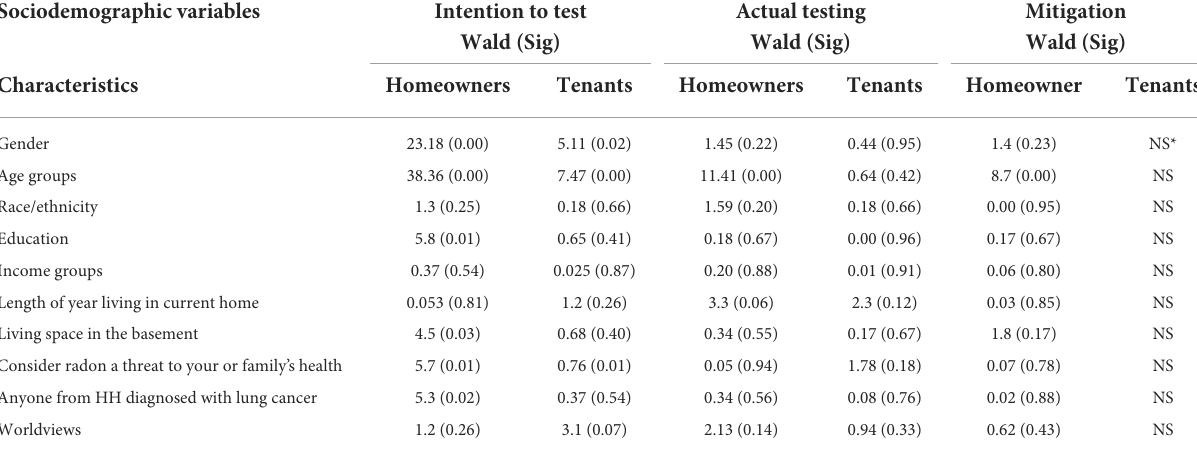
TABLE 3 Sociodemographic determinants vs. protection behaviors. Sociodemographic